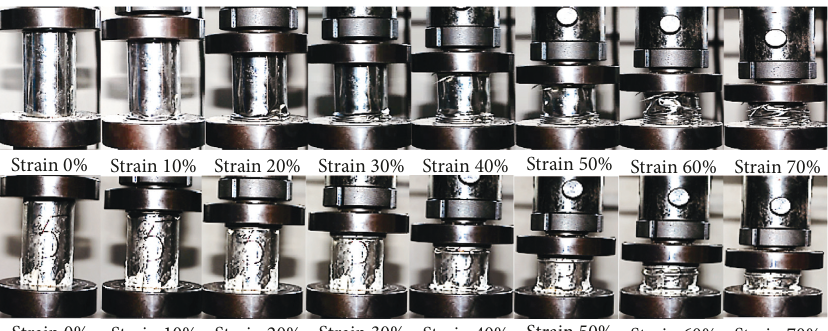
Figure 7: Sequence showing the results of compression on the deformation of epoxy foam-bonding APM composite